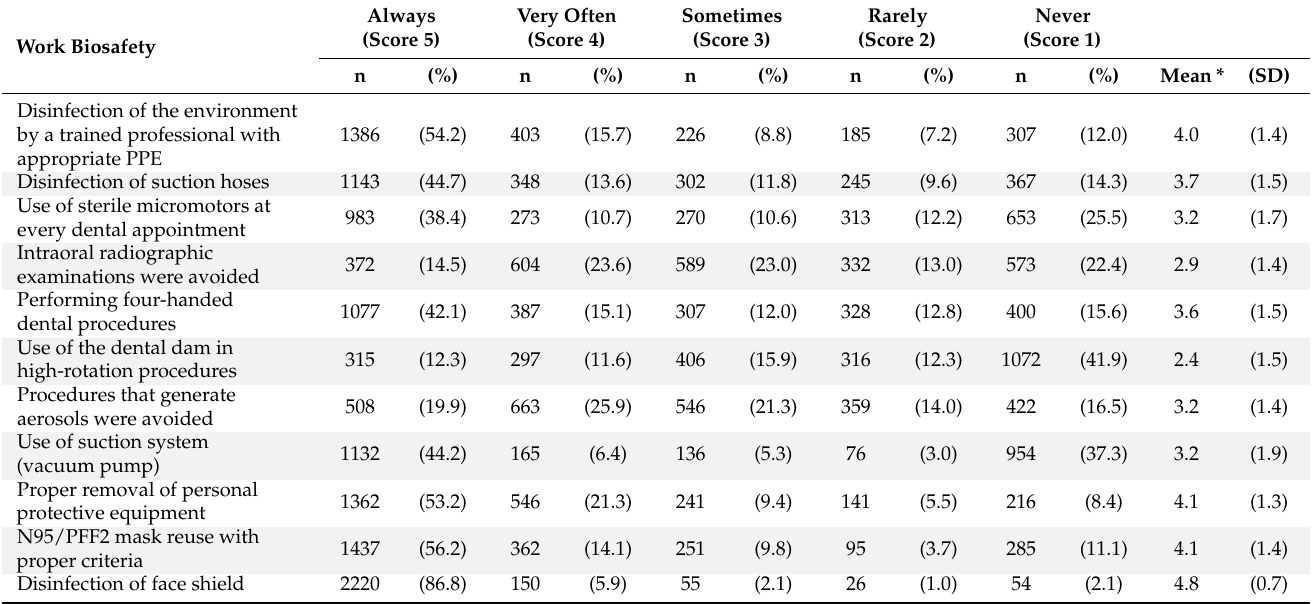
Table 3. Sample of oral health care workers’ distribution regarding the adoption of biosafety measures